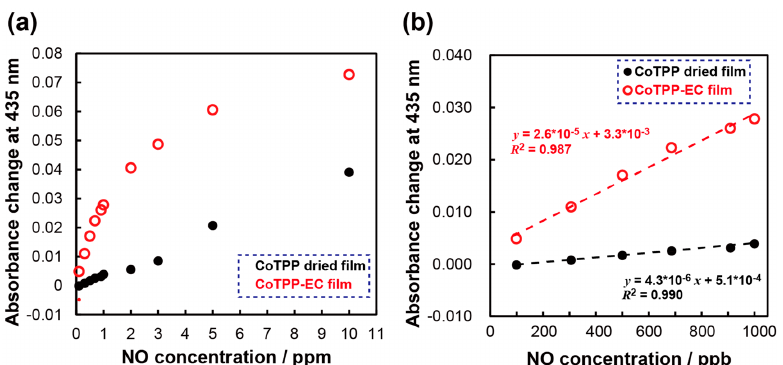
Figure 6. ( a) Calibration curves of NO gas obtained with CoTPP film (black) and CoTPP-EC film. ( b ) Magnified curves in the concentration range of 50 to 1000 ppb.